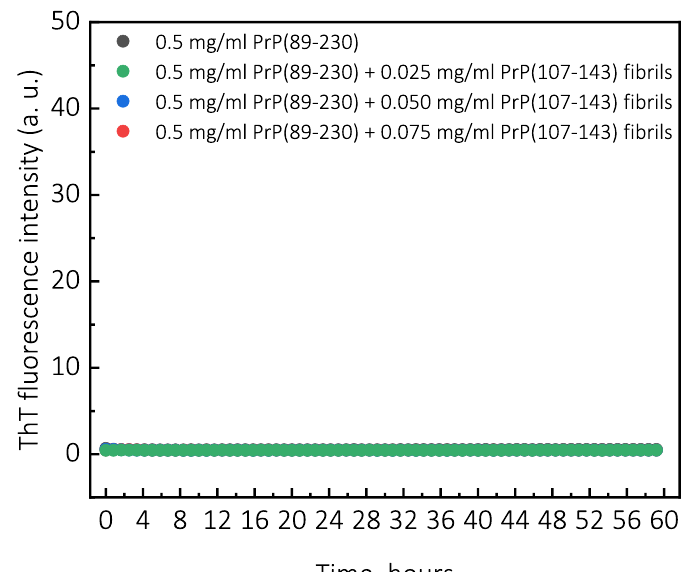
Figure A2. Representative curves of PrP(107-143)-fibril-induced aggregation reaction kinetics monitored at 37 ◦ C under quiescent conditions. For aggregation experiments, solutions of 0.5 mg/mL of monomeric PrP(89-230) protein in 1 M GuHCl, 3 M Urea, 1 × PBS (pH 7.4), containing 50 µ M ThT were supplemented with none, 0.025, 0.050, or 0.075 mg/mL of PrP(107-143) fibrils and incubated under quiescent conditions at 37 ◦ C temperature. Aggregation kinetics were monitored by ThT fluorescence